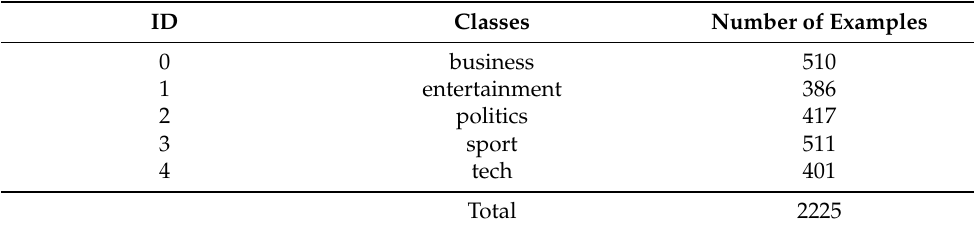
Table 4. BBC Text dataset.